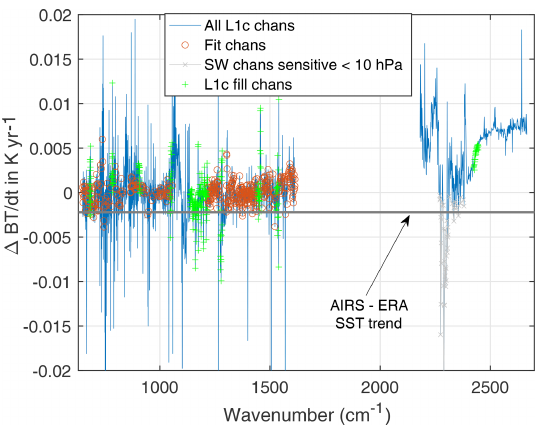
Figure 9. Linear trends in the anomaly fit residuals, averaged over all 365 16d time steps for ± 30 ◦ latitude. Note the linear trend in the shortwave in these fit residuals. Also shown is the trend difference (ERA-I SST – AIRS SST) for these data.